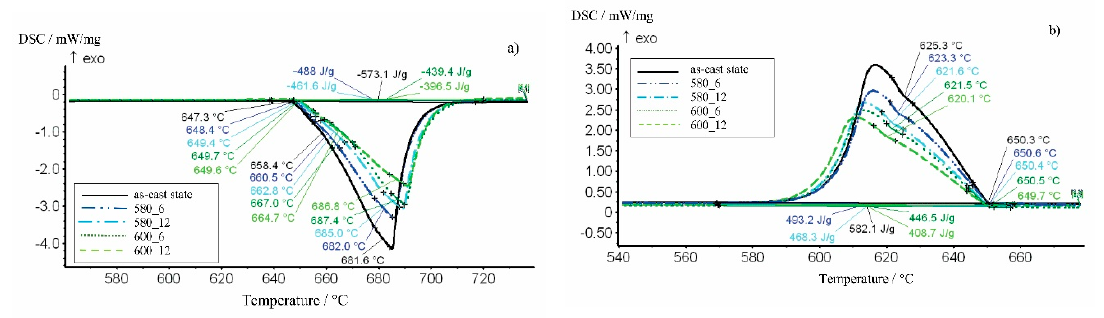
Figure 3. Heating ( a ) and cooling ( b ) Differential scanning calorimetry (DSC) curves of the investigated samples after homogenization.